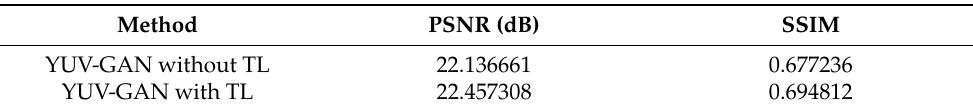
Table 6. Average PSNR and SSIM values of reconstructed images from the Sentinel-2A test set (YUV-GAN with or without